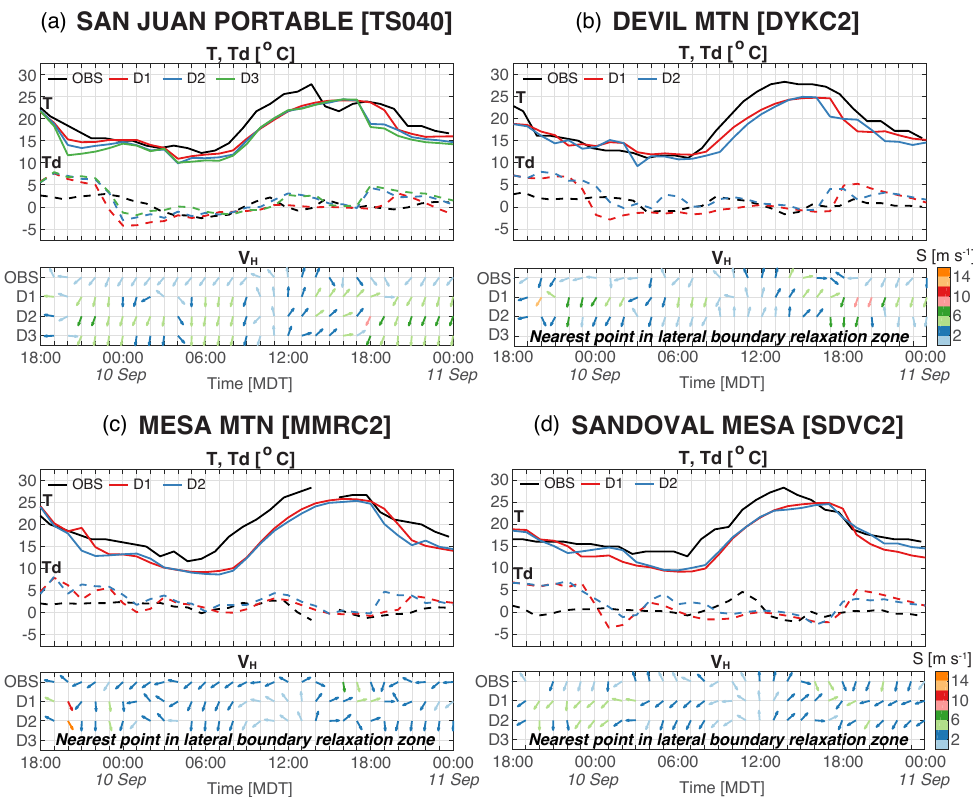
Figure 5. Time series of observed and simulated temperature (T), dewpoint (Td), and horizontal wind vectors (V H ; color scale for wind speed (S) included to right of figure), at four RAWS sites: ( a ) San Juan Portable (TS040), ( b ) Devil Mtn (DYKC2), ( c ) Mesa Mtn (MMRC2), and ( d ) Sandoval Mesa (SDVC2). Note that domain D3 is omitted from panels ( b – d ) because nearest grid points to RAWS sites are in lateral boundary relaxation zone. Temperature and dewpoint are measured at 2 m above ground level (AGL) at all four RAWS stations, and wind speed is measured at either 2 m AGL (TS040) or 6.1 m AGL (DYKC2, MMRC2, and SDVC2); all simulated variables are valid at the lowest grid level (D1: 25 m; D2: 12.5 m; D3: 5 m AGL). See Figure 1c for location of RAWS